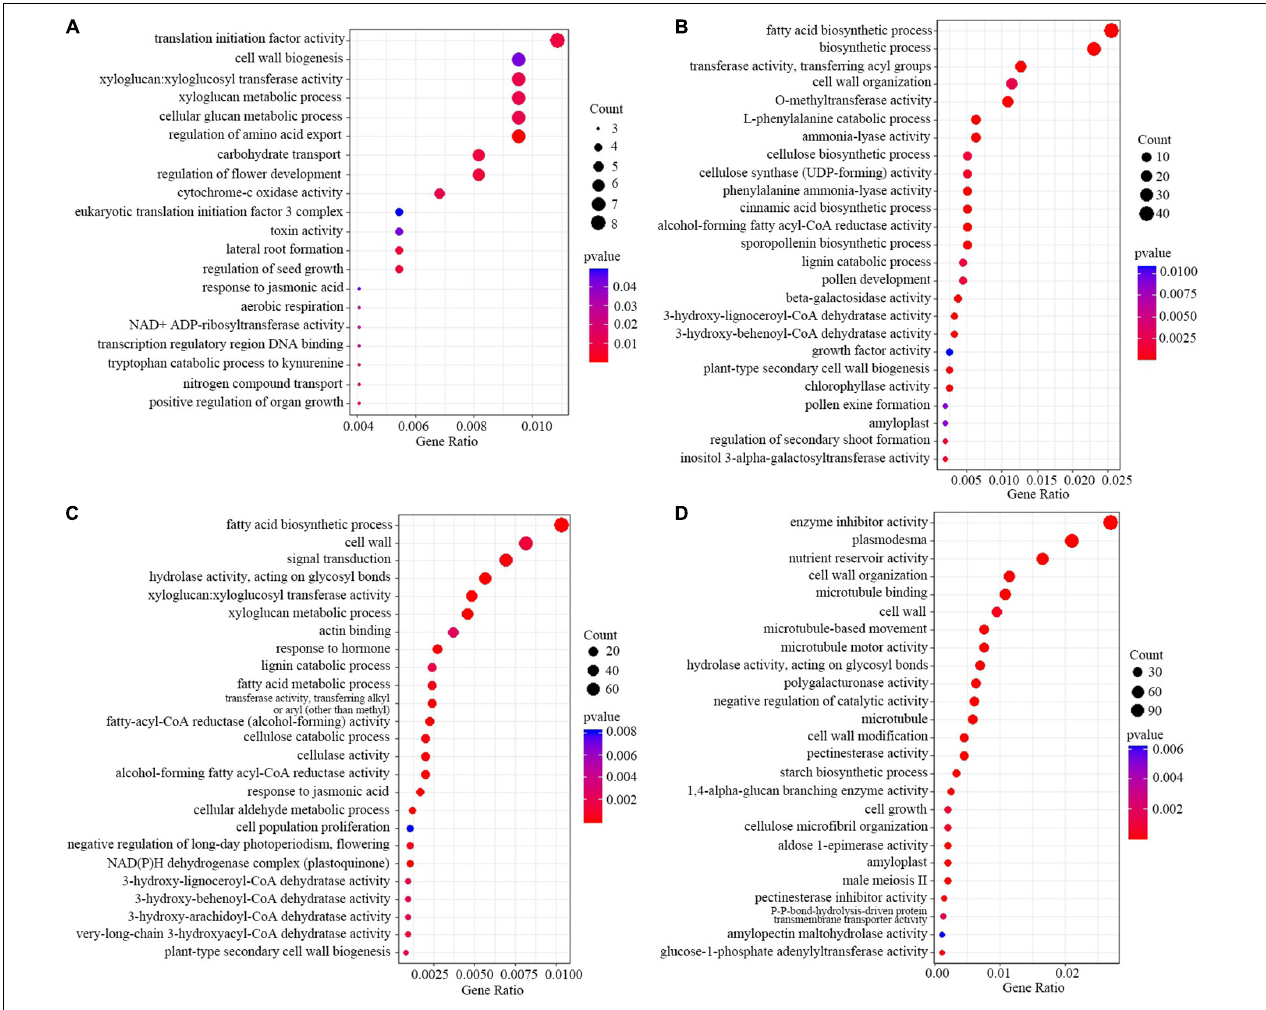
FIGURE 8 | Scatterplots showing the GO enrichment results of cluster 1 (A) , 2 (B) , 3 (C) , and 4 (D)